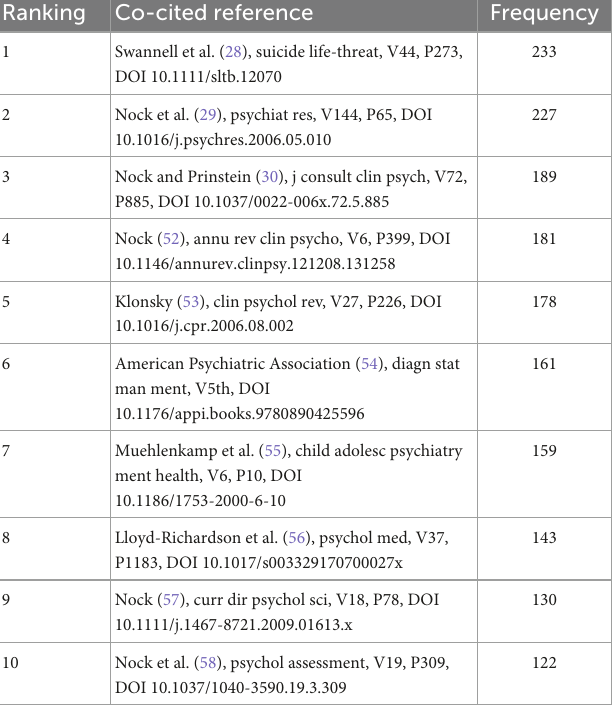
researchers grasp developmental trends in this field. 799 publications related to NSSI were searched from the